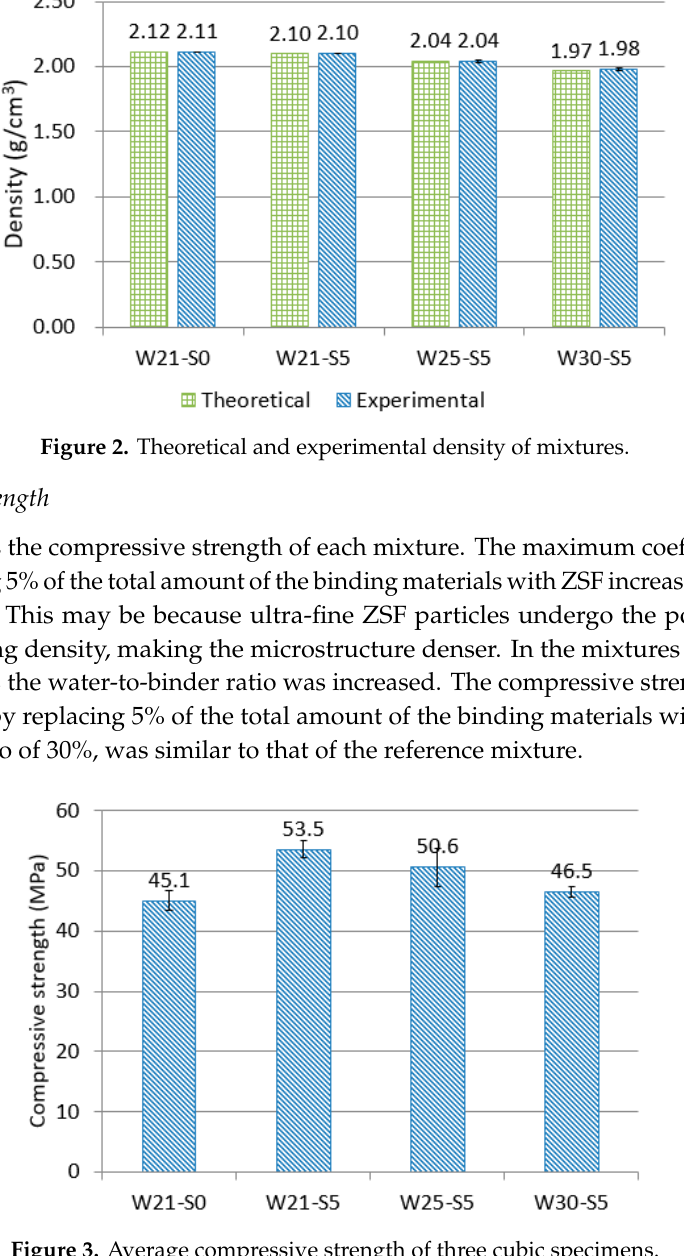
Figure 3. Average compressive strength of three cubic specimens .